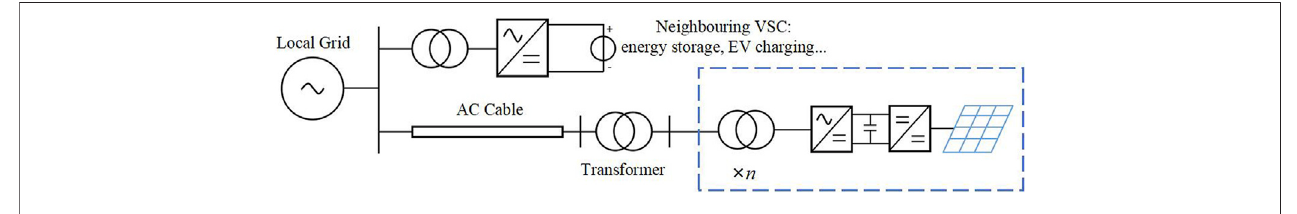
FIGURE 2 | Schematic diagram of the study system.